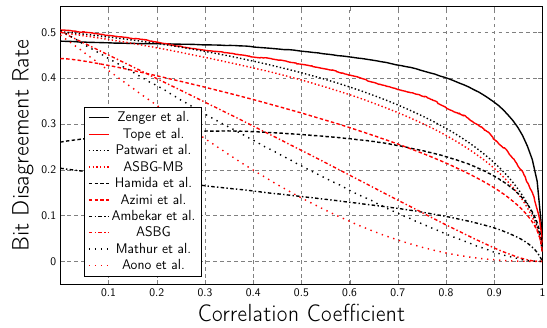
Figure 3: Bit disagreement rate versus correlation coefficient for different quantization schemes.